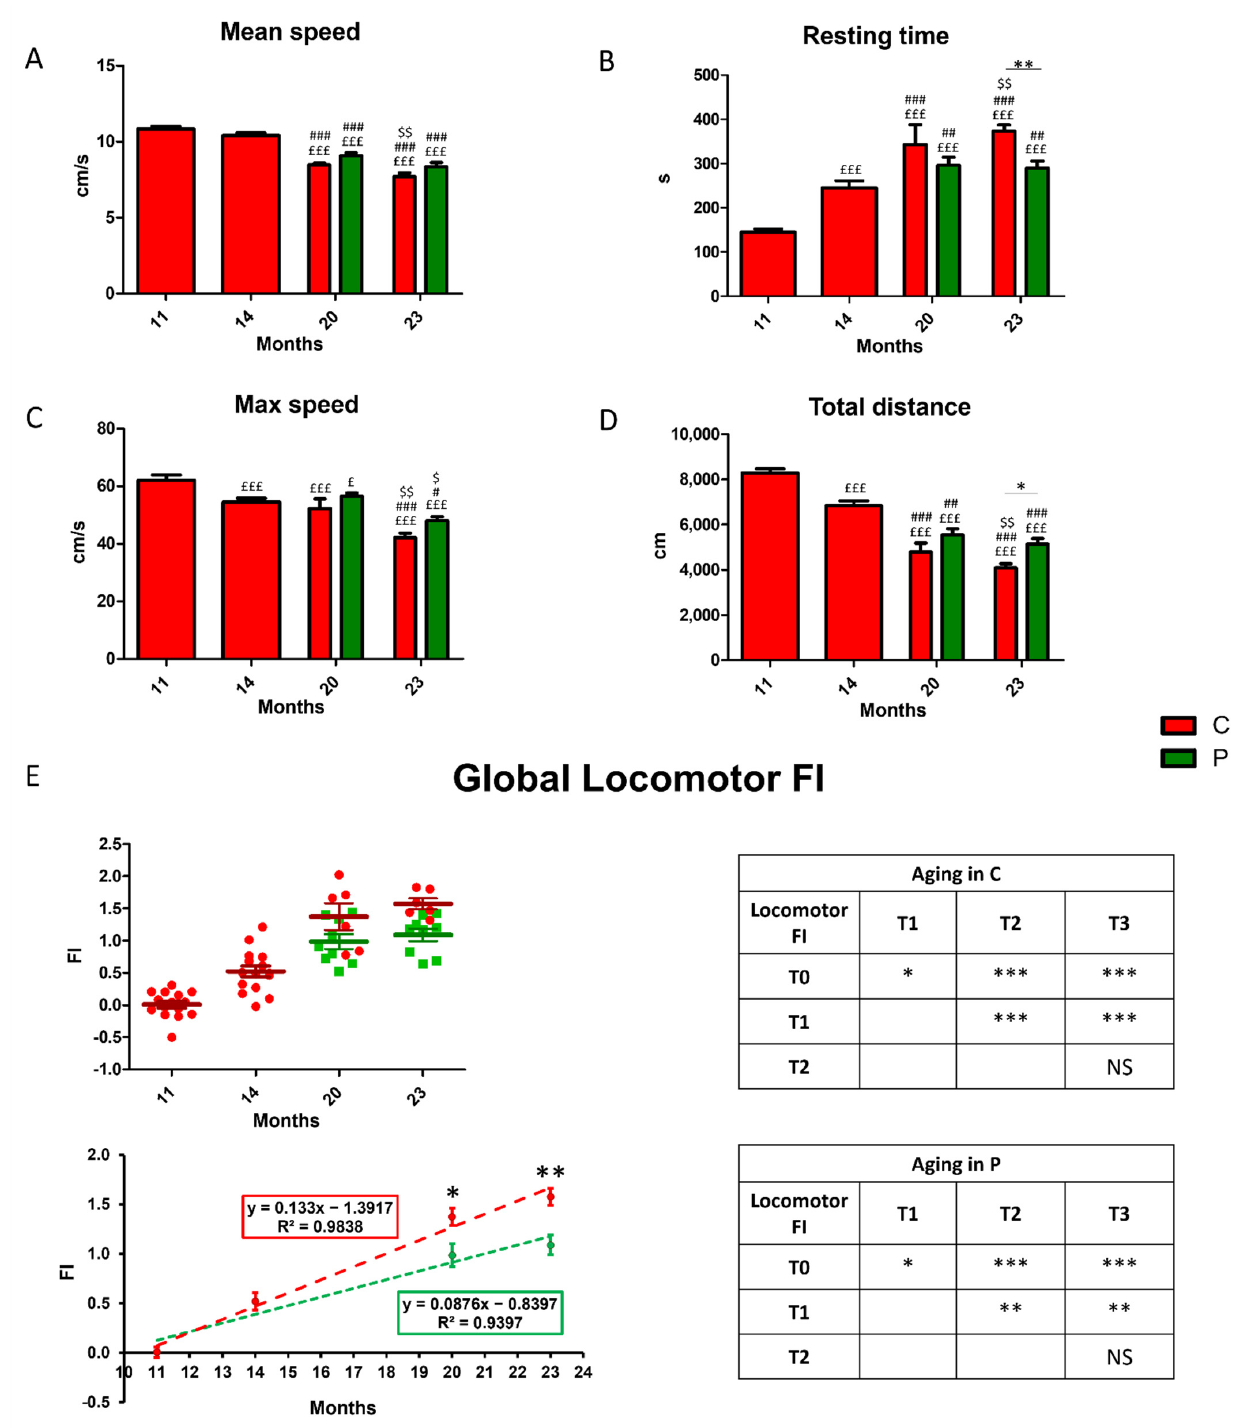
Figure 3. Decline of locomotor performances during physiological aging in control animals and recovery in He2 primordium extract-supplemented mice. ( A ): Mean speed (cm/s); ( B ): resting time (s); ( C ): max speed (cm/s); ( D ): total distance (cm). ( E ): Scatter plot of global locomotor FIs (up left), linear least-square regression of experimental points (down left) and separated tables showing statistical results regarding aging effect in wild-type controls (red, up right) and treated (green, down right) animals. For each panel, red bars or dots show data regarding control animals (C group), while green bars or dots show data belonging to treated mice (P group). Statistically significant values: p < 0.05 ( £, #, $, *); p < 0.01 ( ##, $$, **); p < 0.001 ( £££, ###,